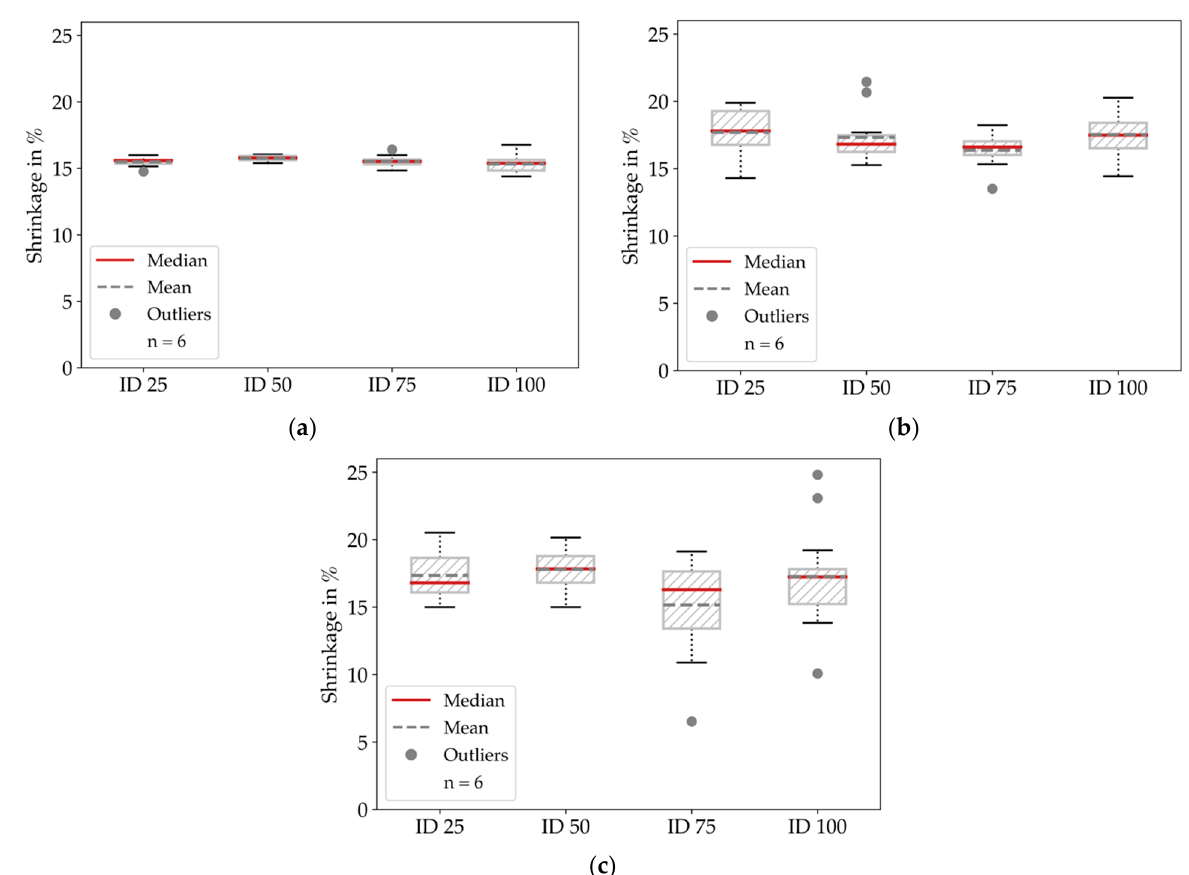
Figure 8. Global shrinkage behavior for all specimens and infill degree configurations: ( a ) Length (inplane, x -axis); ( b ) Width (inplane, y -axis); ( c ) Height (stacking direction, z -axis). The results show the slightest deviations for the length dimension. Table 2. Mean values of the sinter shrinkage for all configurations. x -axis and y -axis represent the printing plane, and z -axis represents the stacking direction.